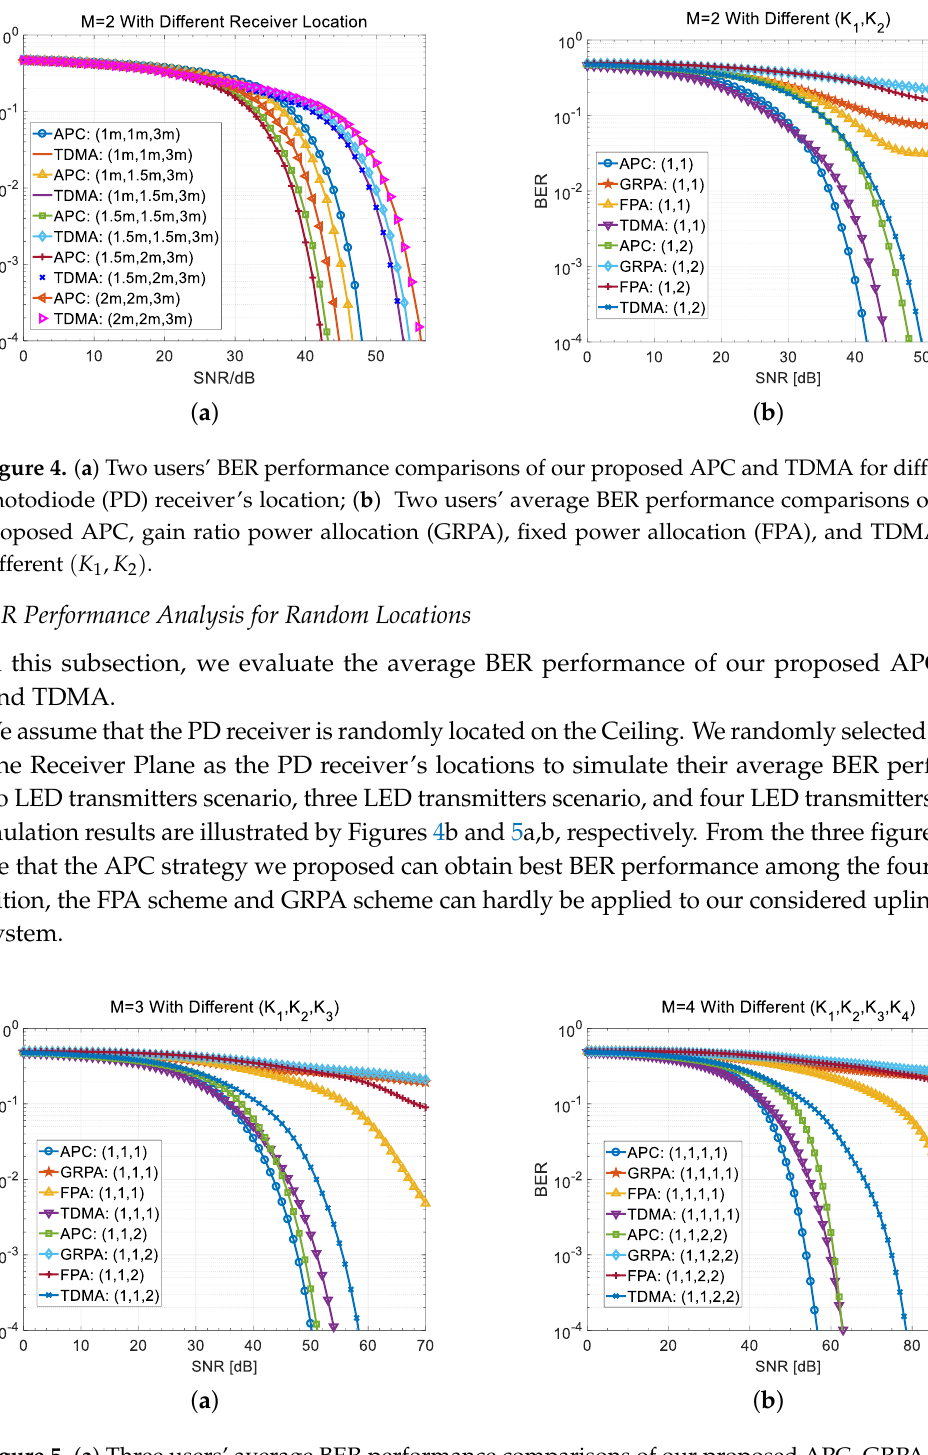
Figure 5. ( a ) Three users’ average BER performance comparisons of our proposed APC, GRPA, FPA and TDMA for different p K 1 , K 2 , K 3 q ; ( b ) Four users’ average BER performance comparisons of our proposed APC, GRPA, FPA, and TDMA for different p K 1 , K 2 , K 3 , K 4 q